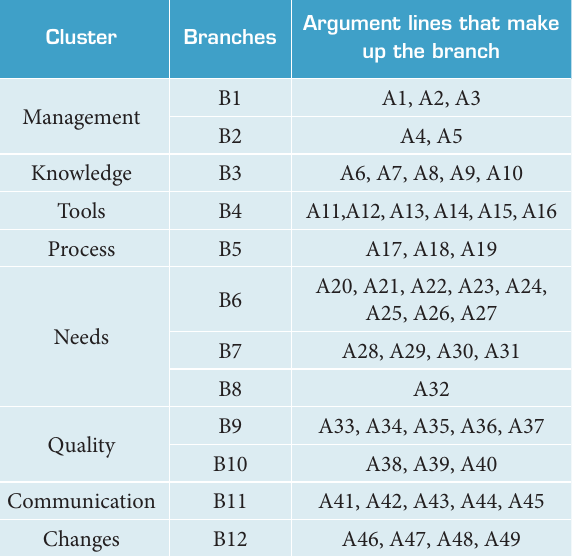
Figure 3. Tree of Fundamental Points of table 5. Branches on the congregated cognitive map.